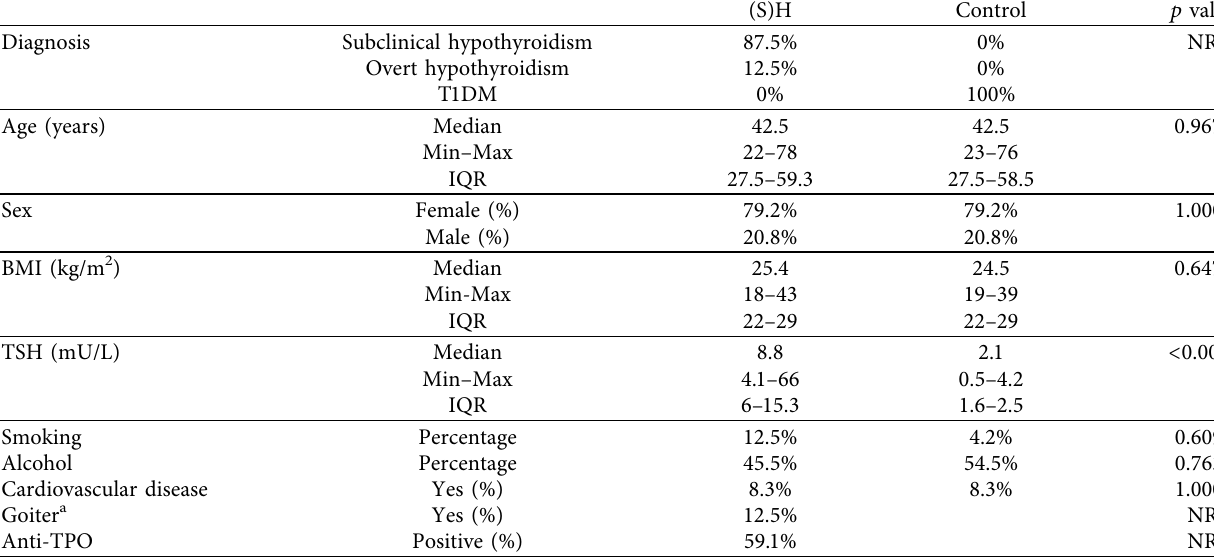
Table 1: Baseline characteristics.